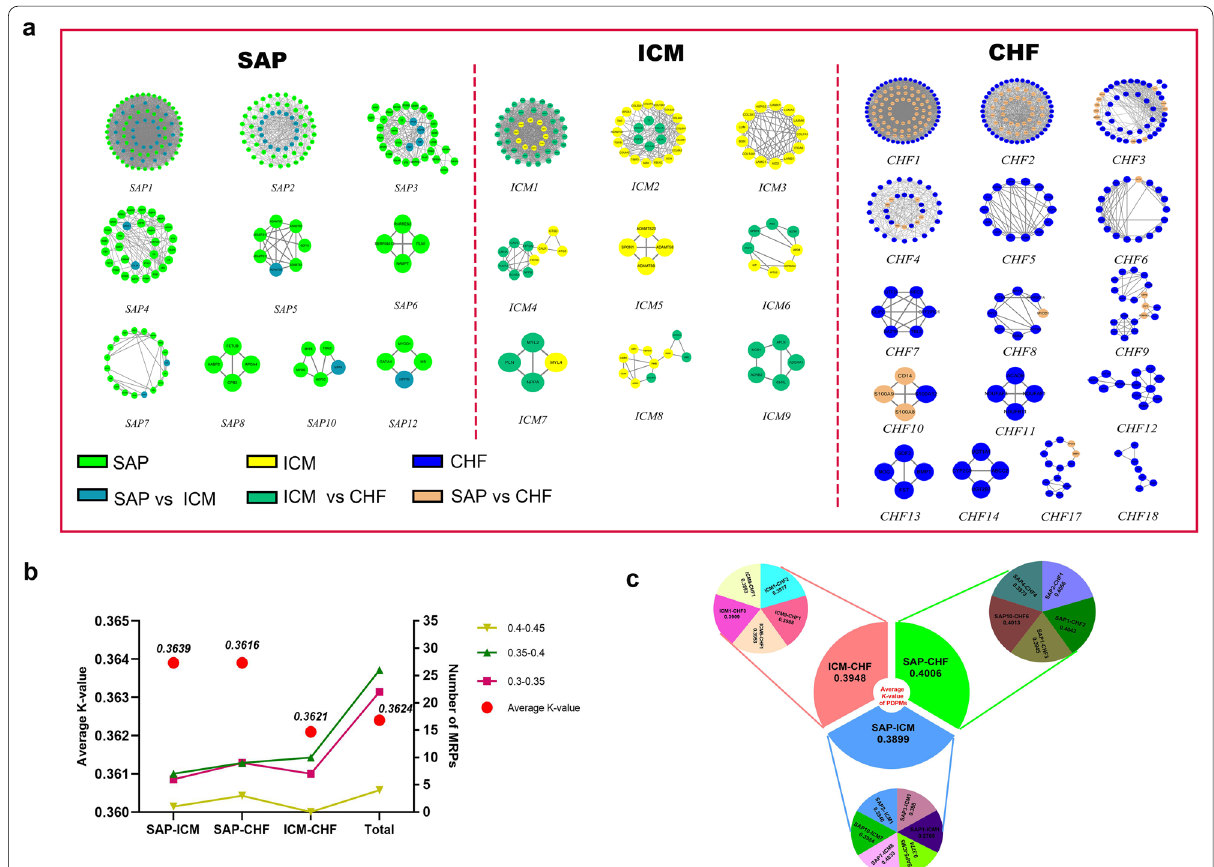
Fig. 2 Identification of module and module reconstructional pairs. a Identification of module and module reconstructional pairs. b The distribution of the K ‑value. c The distribution of the K ‑values of the